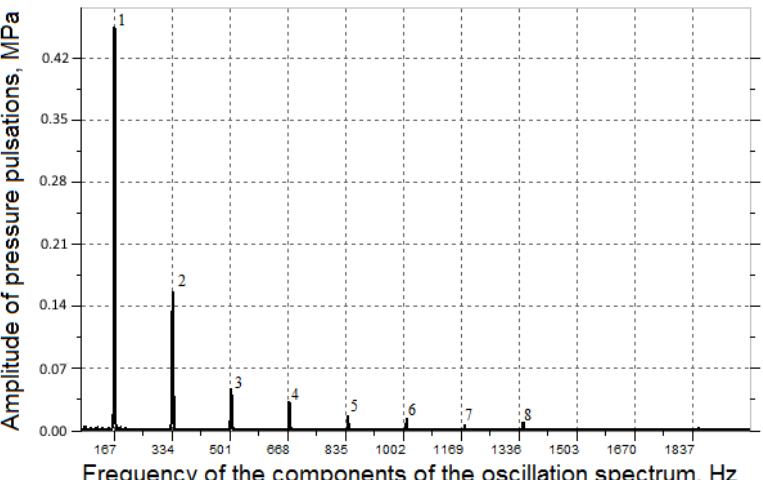
Figure 23. Spectrum of pressure pulsation amplitudes at pump speed n = 1000 rpm. Amplitudes of pressure pulsations at the pump outlet for the four harmonics are built by approximating functions A p1,2,3,4 ( f ) (Figure 24). The regression dependences of one and two harmonics are extrapolated at (1250 ... 2500) rpm.